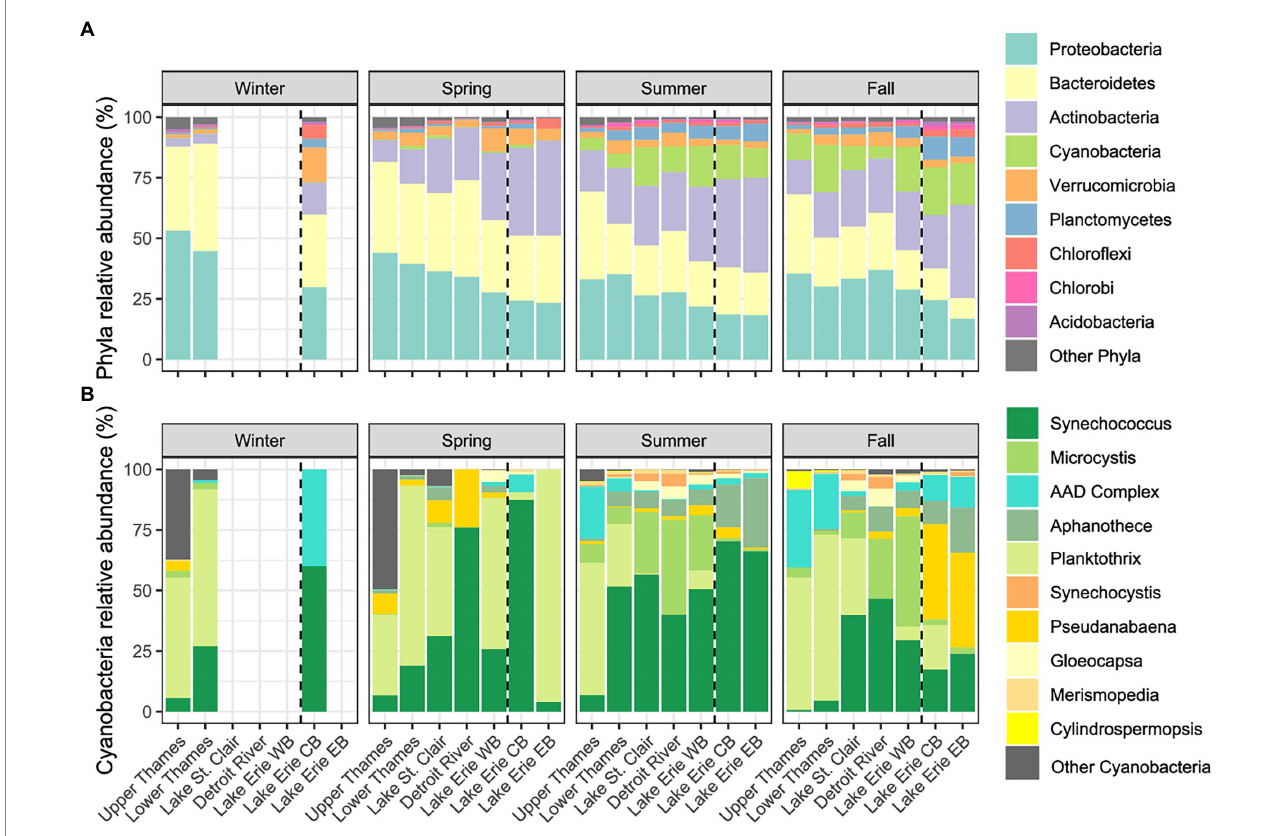
FIGURE 3 Relative abundances of the main microbial phyla expressed as % of the microbial community (A) and cyanobacterial genera expressed as % of the cyanobacterial community (B) along the water continuum and as a function of the different seasons. The Western Basin (WB) is separated by a dotted line from CB for the Central Basin (CB) and Eastern Basin (EB). Not all systems were sampled during winter (for sampling frequency see Supplementary Table 1).